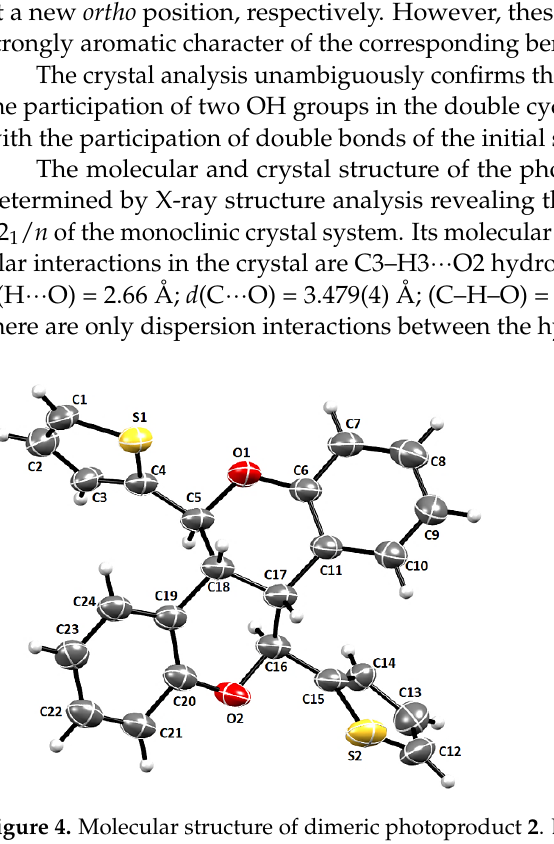
Figure 3. 1 H NMR spectra (CDCl 3 ) of the starting substrate E - 1 ( a ), and photoproducts Z - 1 ( b ), dimer 2 ( c ) and oxygenated cyclization product 3 ( d ).